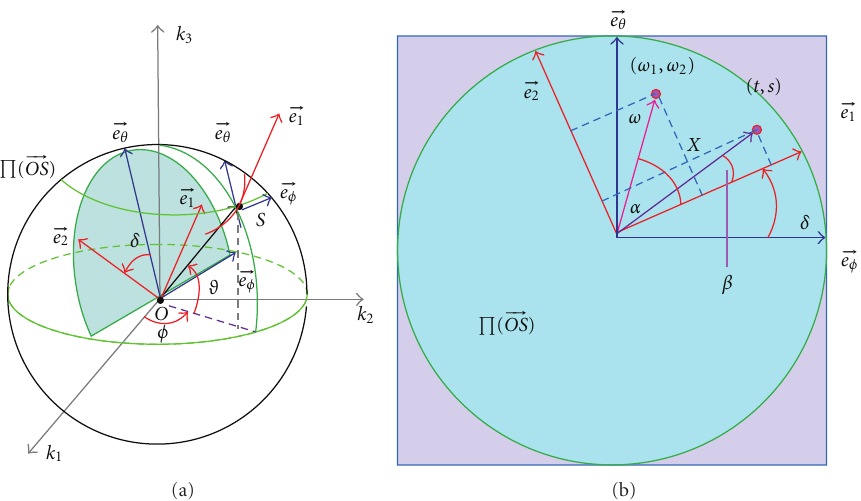
Figure 6: Euler angles. (a) The Euler angles of the frequency plane and (b) the rotation angle of frequency plane relative to the detector plane.